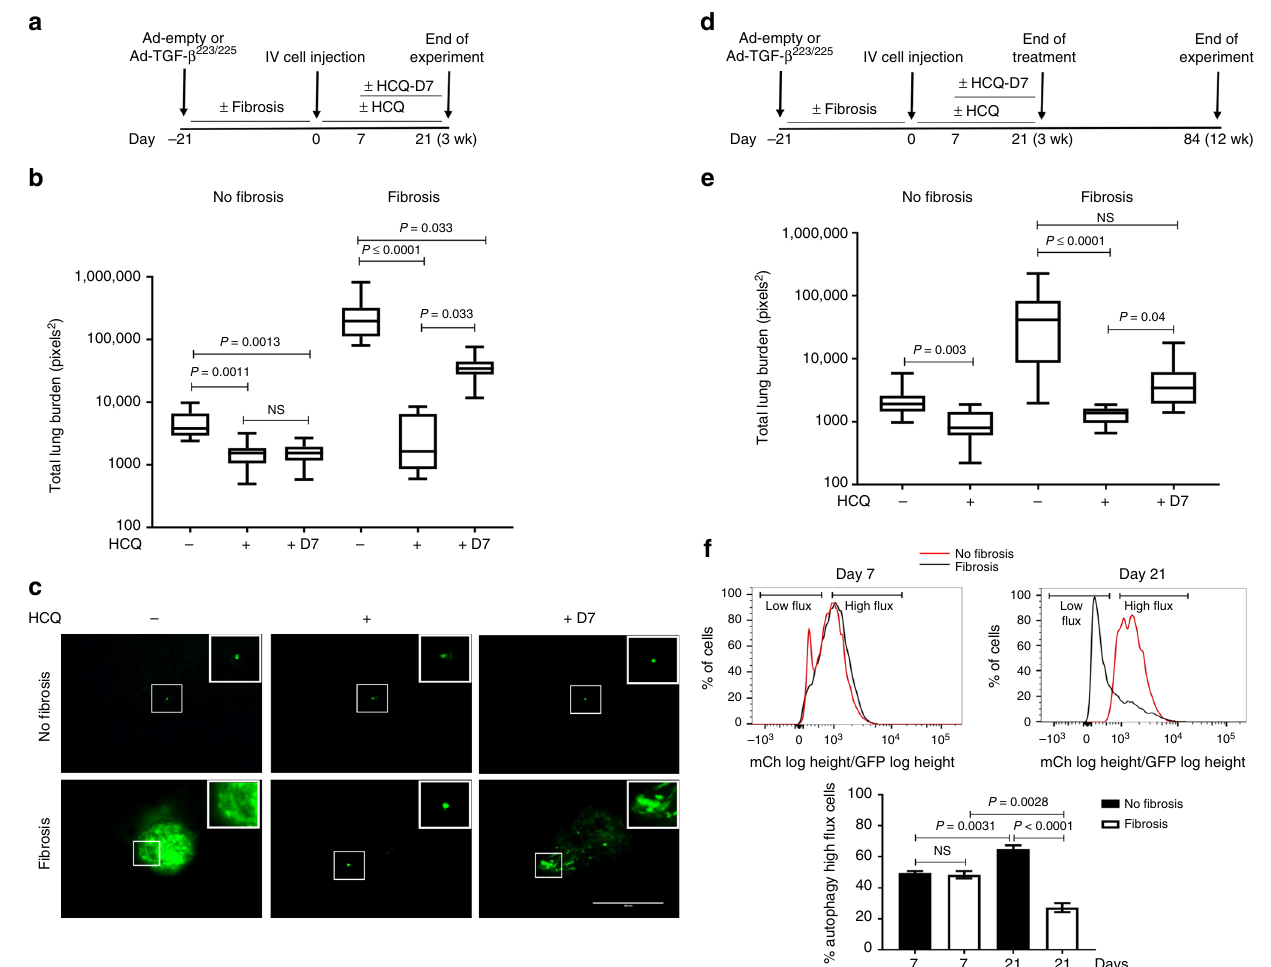
Fig. 4 Delayed autophagy inhibition increases viable cells in fi brotic lungs. a Experimental design. b Total lung surface burden of CD1 nu/nu mice receiving Ad-empty (No fi brosis) or Ad-TGF- β 223/225 (Fibrosis) and tail vein injections of 1 × 10 6 D2.0 R GFP cells, followed by vehicle ( − ), 50 mg/kg body weight of HCQ 5 days a week for 3 weeks ( + ) or vehicle daily for 7 days followed by 50 mg/kg body weight of HCQ 5 days a week for additional 2 weeks ( + D7) (mean ± s.e.m, n = 9 – 10 mice per group. Comparisons by Kruskal – Wallis, Dunn ’ s post test). c Representative images of single dormant cells and multicellular metastatic lesions expressing GFP in the lung from the experiment in b , scale bar is 400 μ m. d Similar experiment to that in a , except that the time animals were followed after the cessation of treatment with HCQ to the fi nal study endpoint that was extended for additional 9 weeks. e Total lung surface D2.0R GFP cell burden from experiment d of CD1 nu/nu mice receiving Ad-empty (No fi brosis) or Ad-TGF- β 223/225 (Fibrosis) and tail vein injections of 1 × 10 6 D2.0 R GFP cells, followed by vehicle ( − ), 50 mg/kg body weight of HCQ 5 days a week for 3 weeks ( + ) or vehicle daily for 7 days followed by 50 mg/kg body weight of HCQ 5 days a week for additional 2 weeks ( fi brosis group only) ( + D7) (mean ± s.e.m, n = 9 – 10 mice per group. Comparisons by Kruskal – Wallis, Dunn ’ s post test). f High autophagy fl ux D2.0 R cells present in the lung of CD1 nu/nu mice receiving Ad-empty (No fi brosis) or Ad-TGF- β 223/225 (Fibrosis) and tail vein injections of 1 × 10 6 D2.0 R mCherry-GFP-LC3 cells after 7 or 21 days (mean ± s.e.m, n = 15 mice per group. Comparisons by Kruskal – Wallis, Dunn ’ s post fi ndings, the delay of HCQ administration for 7 days after cell injection resulted in equivalent metastatic total tumour burden compared to controls (Fig. 5a, b) suggesting that inhibition of autophagy has a minimal effect once the dormant-to-proliferative switch has occurred. To further investigate this effect, we per- formed a time course experiment addressing the activation status of autophagy in D2A1 cells before and after their proliferative outbreak in vitro. Figure 5c clearly shows the progressive con- version of LC3-I to its lipidated form LC3-II, indicating the activation of autophagy, from day 3 to day 7 of culture. This period of time overlaps with the quiescent phase of D2A1 cells on BME matrices. On the other hand, a sharp decrease in the expression of both LC3 forms is observable at day 11 of culture, at which D2A1 cells have established a stable proliferative pro fi le when cultured on BME matrices.